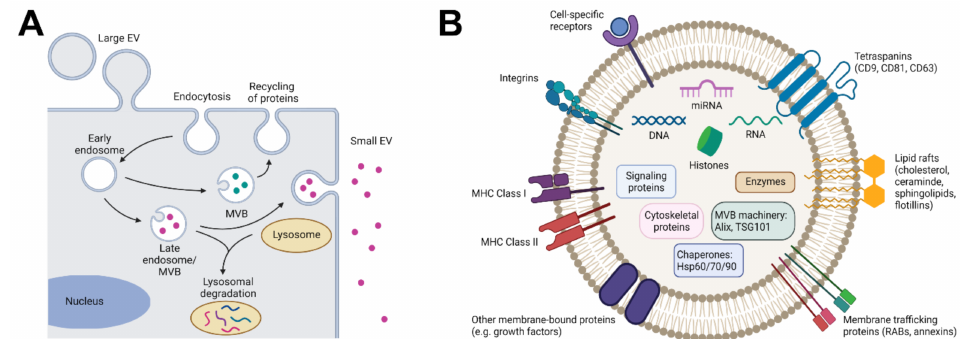
Figure 2. Schematic representation of the formation and composition of extracellular vesicles (EVs). ( A ) Large EVs are generated by budding from the plasma membrane. Small EVs originate in the endocytic pathway by the formation of an early endosome via endocytosis at the plasma membrane. Intraluminal vesicles are formed by the inward budding of the membrane of the late endosome or multivesicular body (MVB). MVBs are targeted for degradation by the lysosome or for secretion by fusion with the plasma membrane. This results in the release of small EVs in the extracellular space. ( B ) The membrane of small EVs contains proteins acquired during their biogenesis (G-proteins (Rabs), Flotillin-1 (FLOT1), etc.), as well as proteins involved in targeting recipient cells (integrins and tetraspanins (CD9, CD81, CD63)) and immune modulation (MHC Class I and MHC Class II receptors). The cytosolic cargo of small EVs includes cell-specific nucleic acids (DNAs, RNAs, miRNAs), histones (H4), proteins from the MVB machinery (ALIX, TSG101), chaperones (HSP70, HSP90, HSP60), signaling proteins (HIF-1 α , β -catenin), enzymes (GAPDH, pyruvate) and cytoskeletal proteins (actin, tubulin). Figure created with Biorender.com, accessed on 28 March